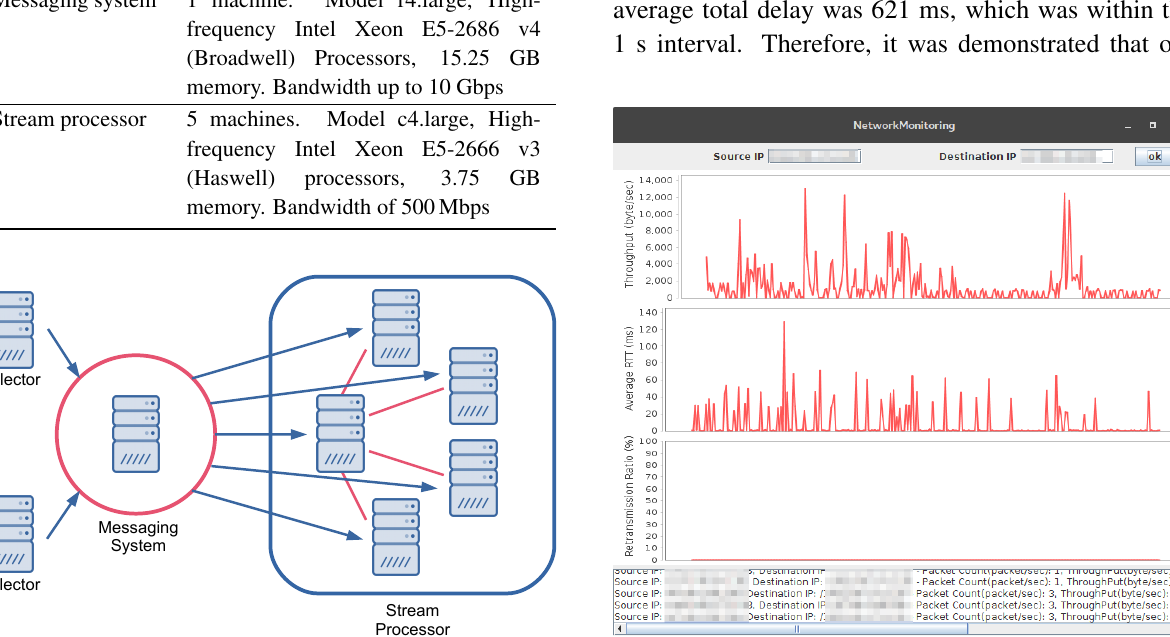
Fig. 4 Network performance measured by our